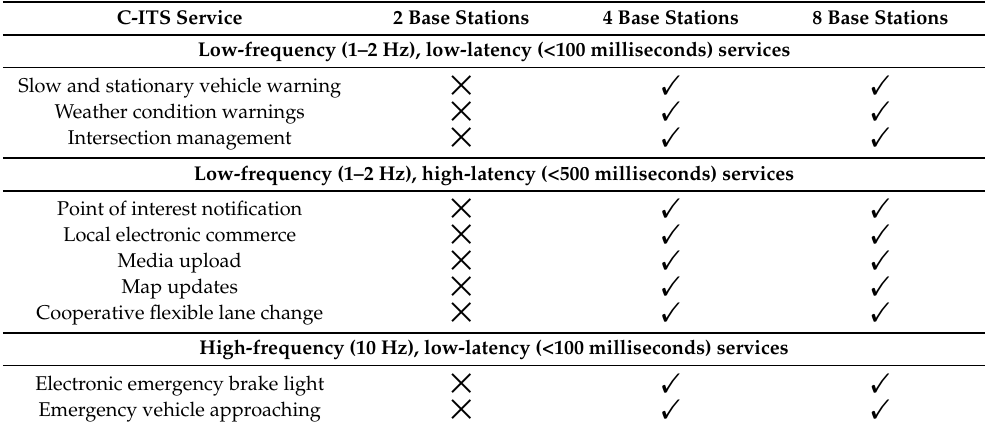
Table 6. Communication requirements of common C-ITS services and their fulfillment by LTE-based C-V2X in the D2D mode 3 and investigated context. Adapted and updated from [16,39].